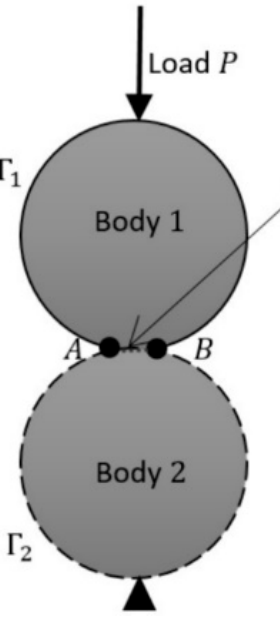
Figure 4. Contact zone between bodies.